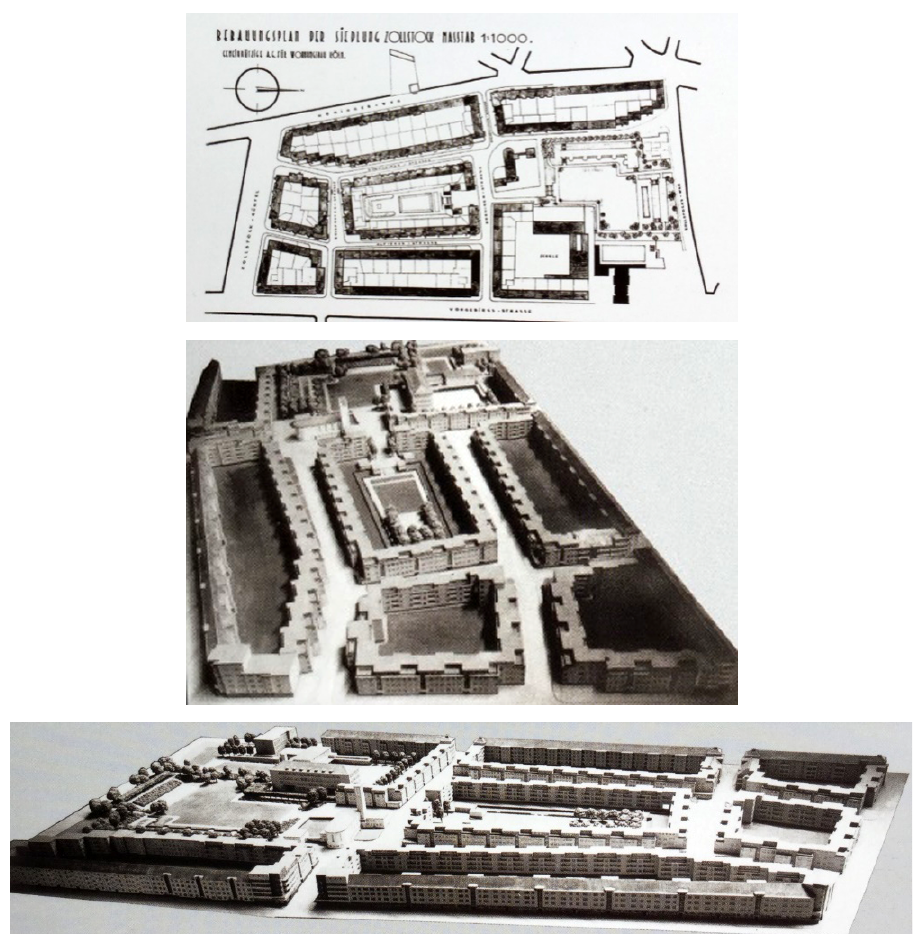
Figure 13. Top: W. Riphahn and C. M. Grod, Zollstock Siedlung , general plan 1929 (Riphahn, 1929). Middle and bottom: Zollstock Siedlung, model 1929 (Mantz, 1929).